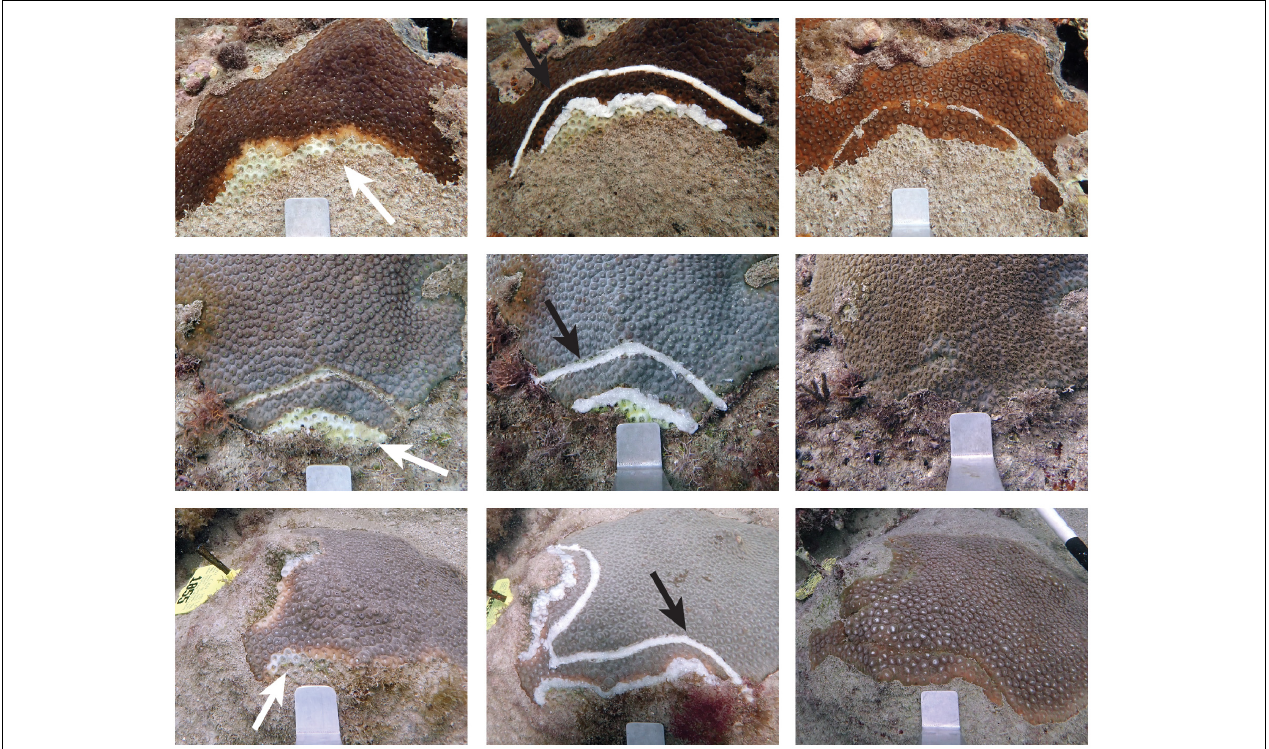
FIGURE 2 | Examples of disease-break application and healing. Disease lesions before treatment are indicated by white arrows and black arrows depict the disease-breaks. The rows are the same lesions over time showing the lesion before treatment (left), upon treatment (Middle), and sometime after treatment (right). The top row lesion was treated on May 6, 2019 and showed disease cessation and healing by June 5, 2019 (1 month). Note that the disease-break contained the spread of the disease where the margin treatment was not effective (right side). The middle row coral was treated on May 15, 2019 and was fully healed by January 31, 2020 (eight and a half months). The bottom row colony was treated on May 19, 2019 and was fully healed on Oct 9, 2019 (5 months).